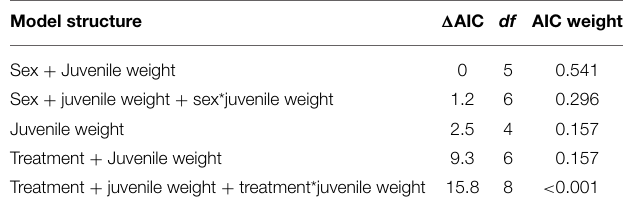
TABLE 5 | Top five models predicting the probability of emerging from the vial.